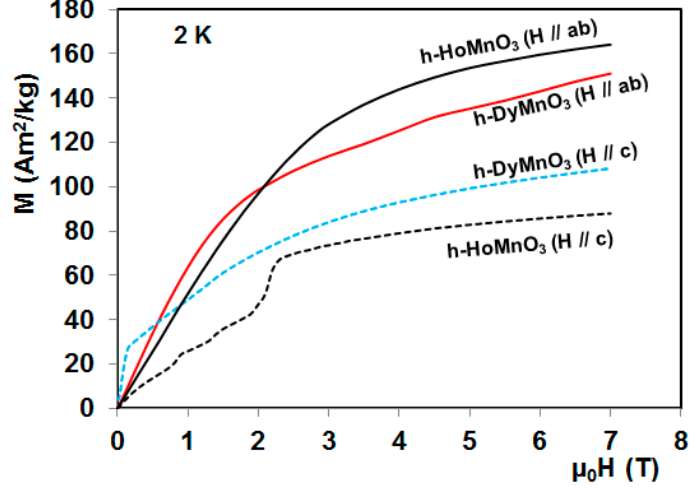
Figure 8. Isothermal magnetization curves at 2 K for hexagonal DyMnO 3 and HoMnO 3 single crystals along their easy- and hard-directions [22,27].